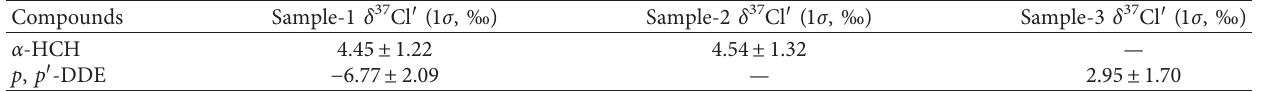
Table 3: Results of groundwater